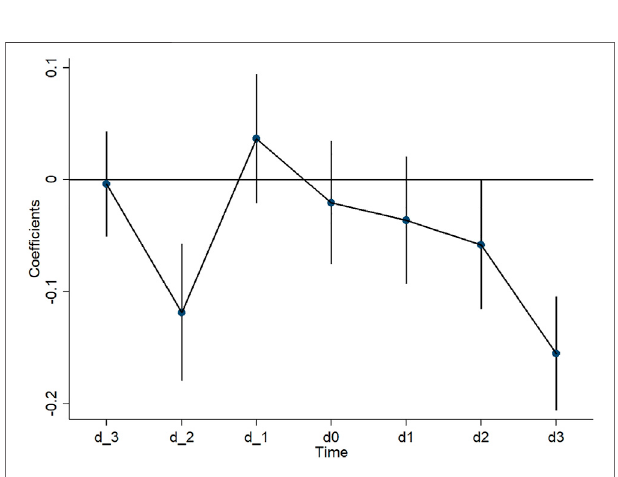
FIGURE 3 | Test results for the assumption of parallel trend. Notes: d0 represents the year in which green credit policy implemented. d_3, d_2, d_1 representthree,twoand1 yearbeforethepolicyisimplemented,respectively. d3, d2, and d1 represent one, two and 3 year after the policy is implemented, respectively.